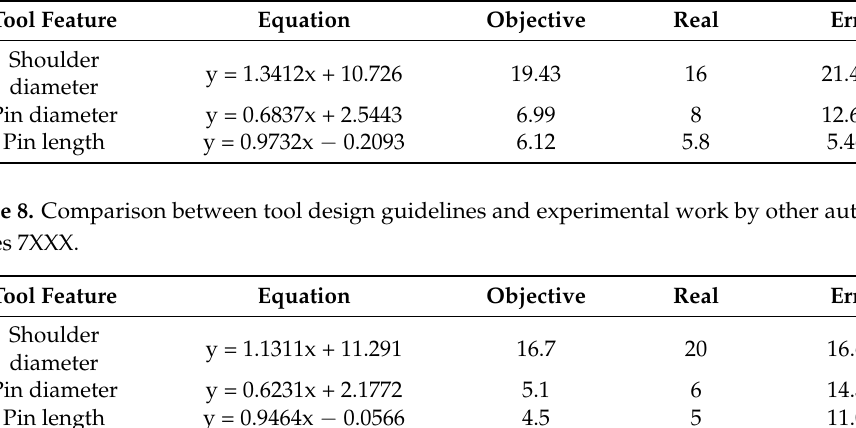
Table 5. Comparison between tool design guidelines and experimental work by other authors for series 2XXX.